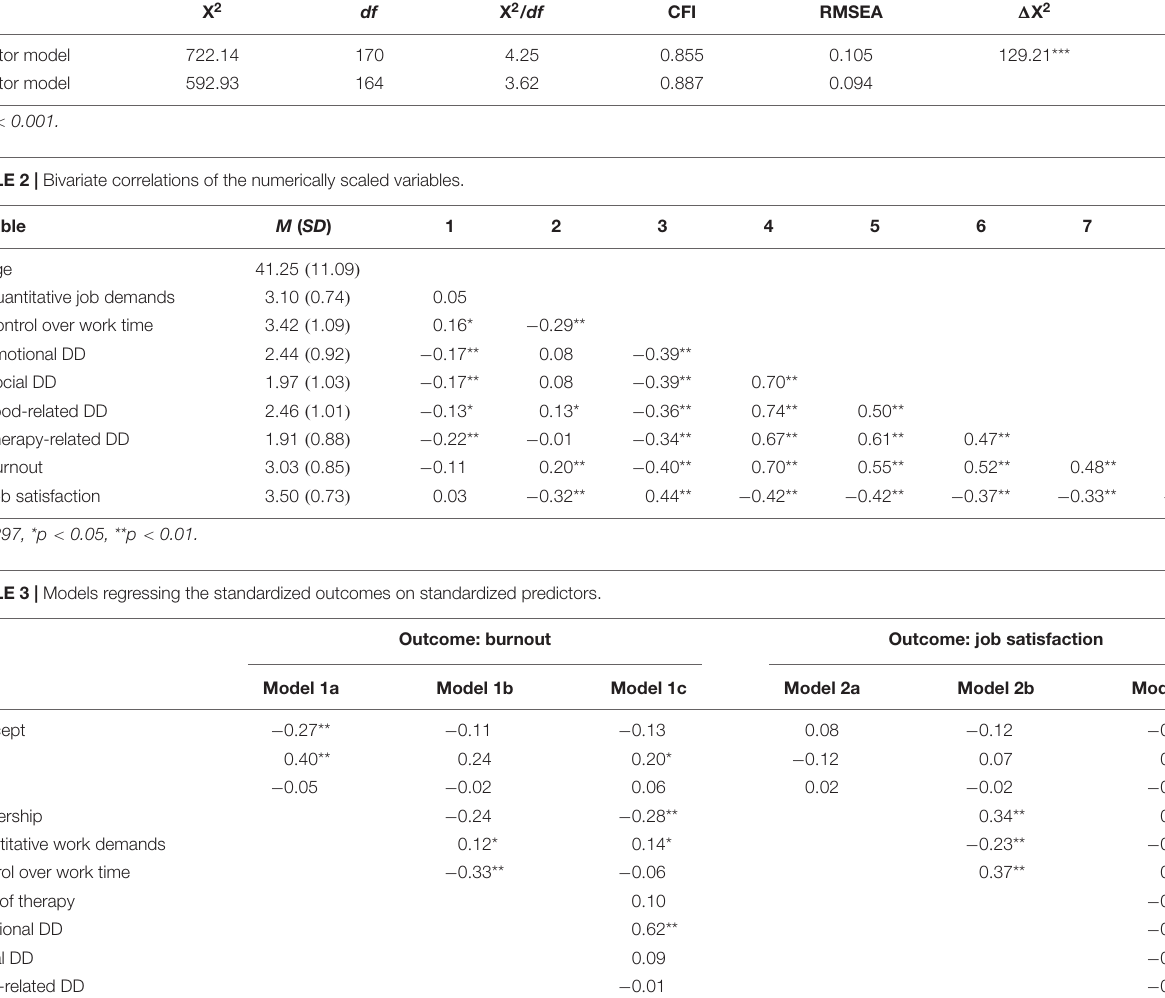
TABLE 1 | Results of the confirmatory analyses testing the 4-factor structure of the PAID. X 2 df X 2 / df